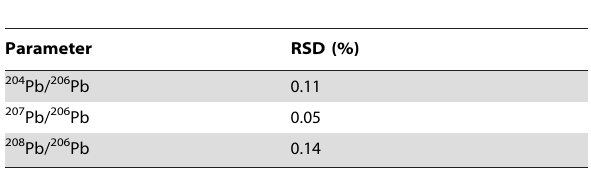
Table 1. Precision by ICP-MS on Pb standard solution isotope